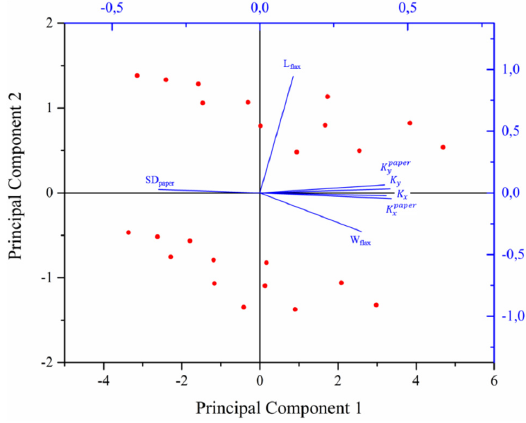
Figure 8. Projection of the first two components in the PCA analysis.